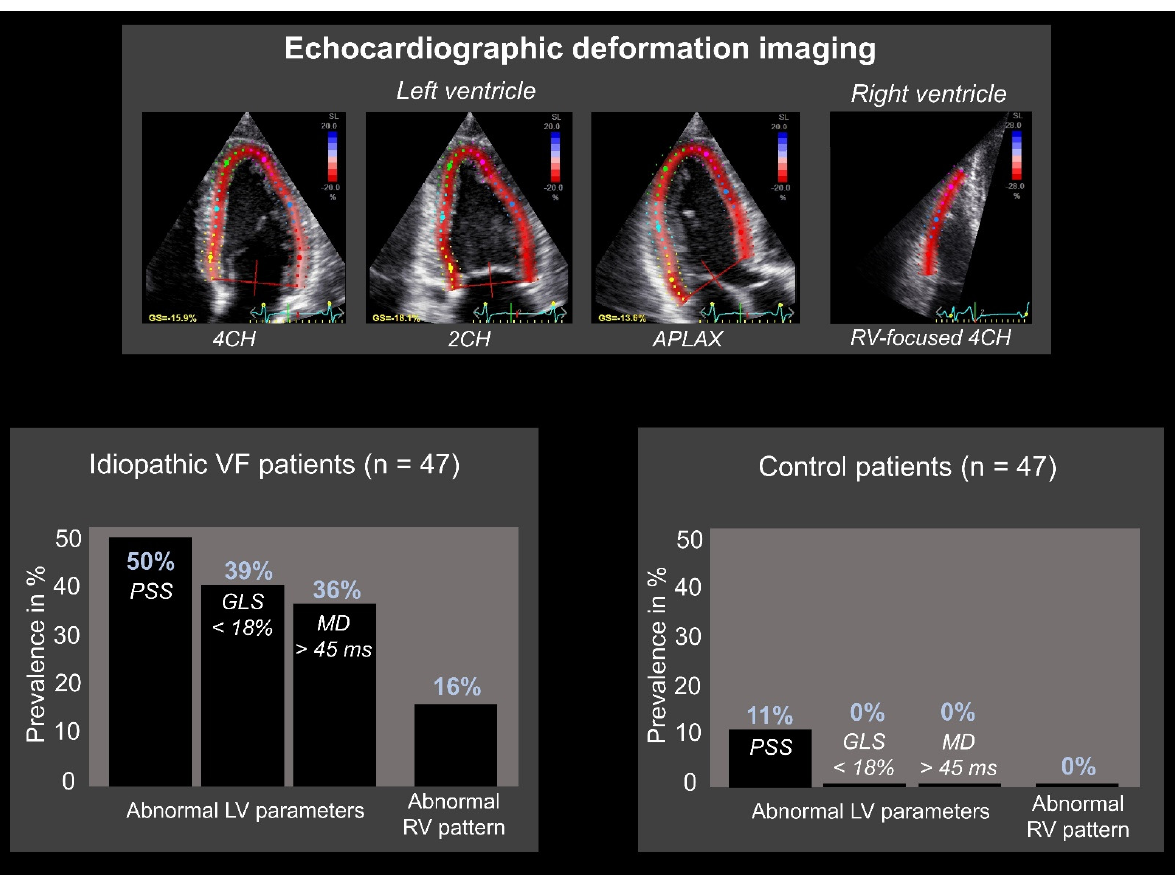
Figure 3. Echocardiographic deformation imaging in patients with idiopathic ventricular fibril- lation. Abnormal results were primarily found in idiopathic ventricular fibrillation (IVF) patients compared to healthy controls. Global deformation imaging includes left ventricular (LV) global lon- gitudinal strain (GLS): defined as “the average global peak strain from three apical views” and LV mechanical dispersion (MD): defined as “the standard deviation of time to peak longitudinal strain from the 18 LV segmental deformation curves”. LV GLS < 18% was considered abnormal, LV MD > 45 ms was considered abnormal. Regional deformation imaging includes postsystolic shortening (PSS): defined as “longitudinal myocardial shortening after aortic valve closure”. PSS ≥ 10% was considered abnormal. 2CH: 2-chamber; 4CH: 4-chamber; APLAX: apical long axis; RV: right ven- tricular. Adapted with permission from Groeneveld et al. [45].